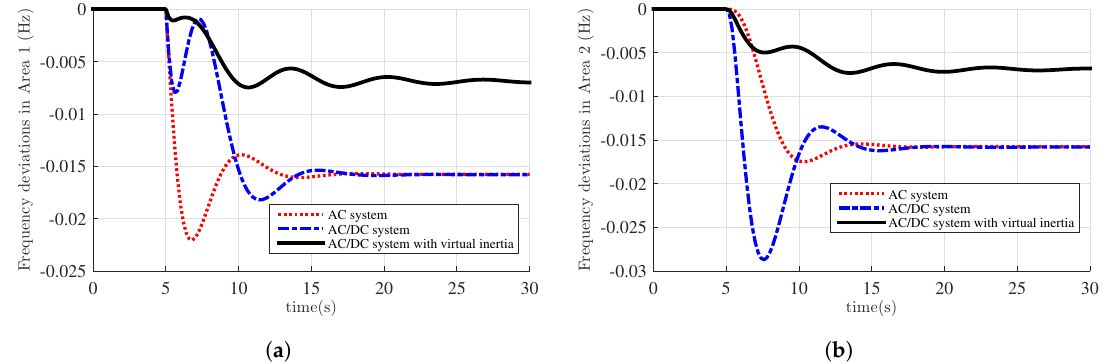
Figure 5. Case 2: results of both areas under a step-load change at 5s and also DoS attacks that start from 6s. ( a ) Frequency deviation of Area 1. ( b ) Frequency deviation of Area 2.